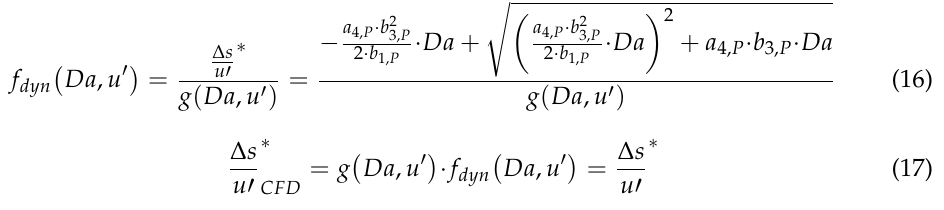
, green). Results for u (cid:48) = 1.83–2.58 m/s CFD